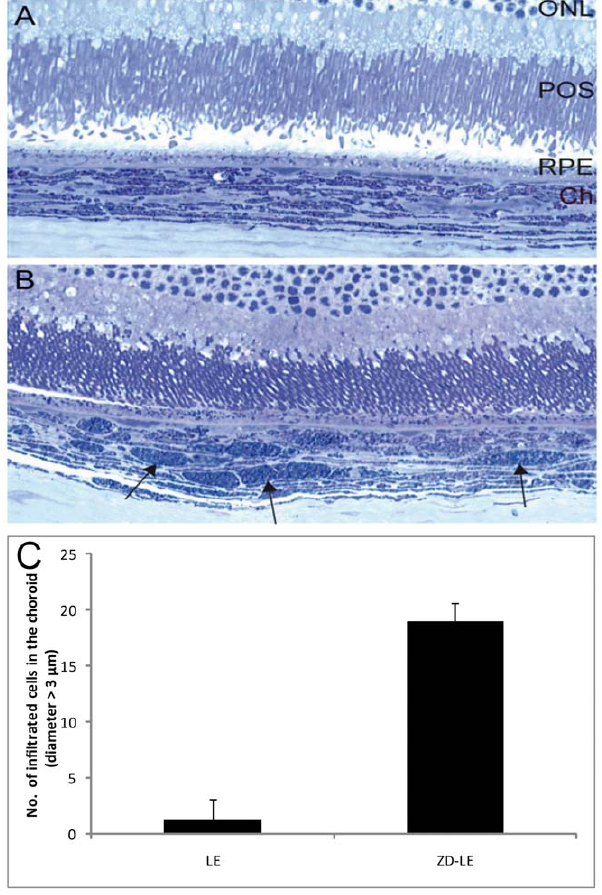
Figure 5. Light microscope semi-thin sections showing the retina-choroid complex of A) LE rat and of B) ZD-LE rat. In B, the choroid shows many large round cells (black arrows) which are absent in the control rats (A). C ) Quantification of infiltrated pigmented cells with a diameter larger than 3 m m in the choroid of LE (1.3 6 1.9) vs . ZD- LE (19 6 1.6) rats. The increase observed in ZD-LE rats is statistically significant (p , 0.0001). Abbreviations: ONL, Outer Nuclear Layer; POS, Photoreceptor Outer Segments; RPE, Retinal Pigment Epithelium; Ch, Choroid.